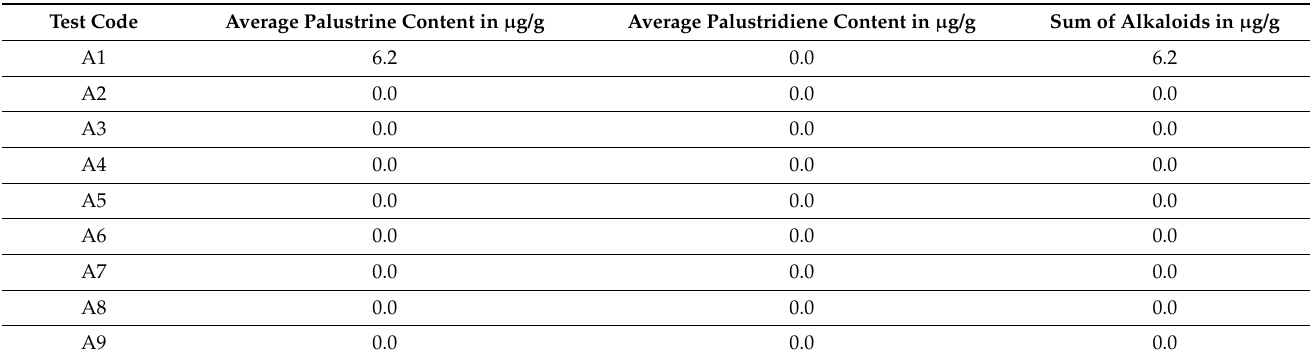
Table 1. The Equisetum alkaloid content of the E. arvense samples analyzed by LC-MSMS. Values of 0.0 indicate results below the LoD.